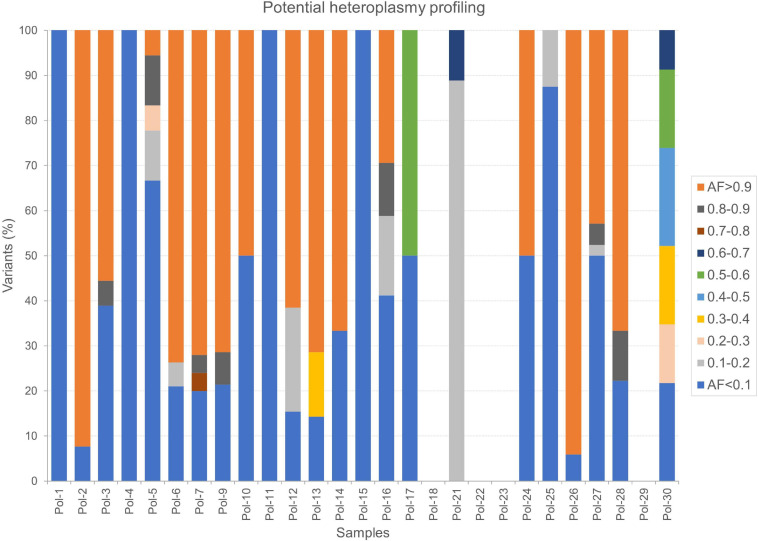
Potential heteroplasmy profiles in Polizzello samples. The percentage of variants in each sample was calculated considering all the ranges of variant allele fraction. Here, 5% was the lowest threshold used to capture information.